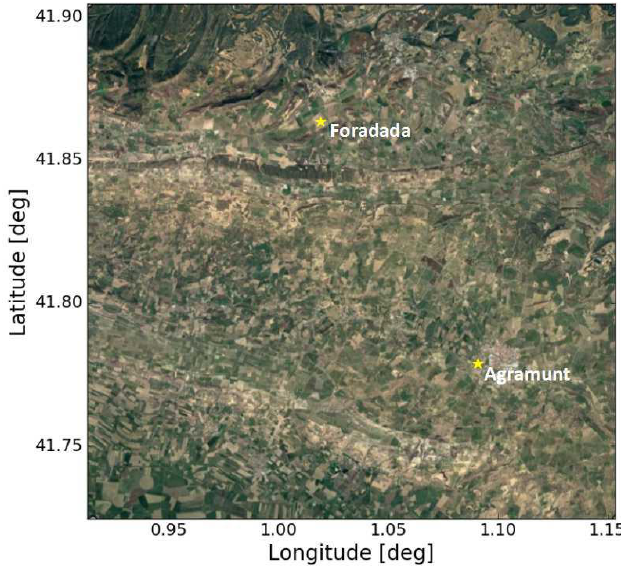
Figure 1. Study area in Urgell, Catalunya (20 km × 20 km) with ground measurements (yellow stars).